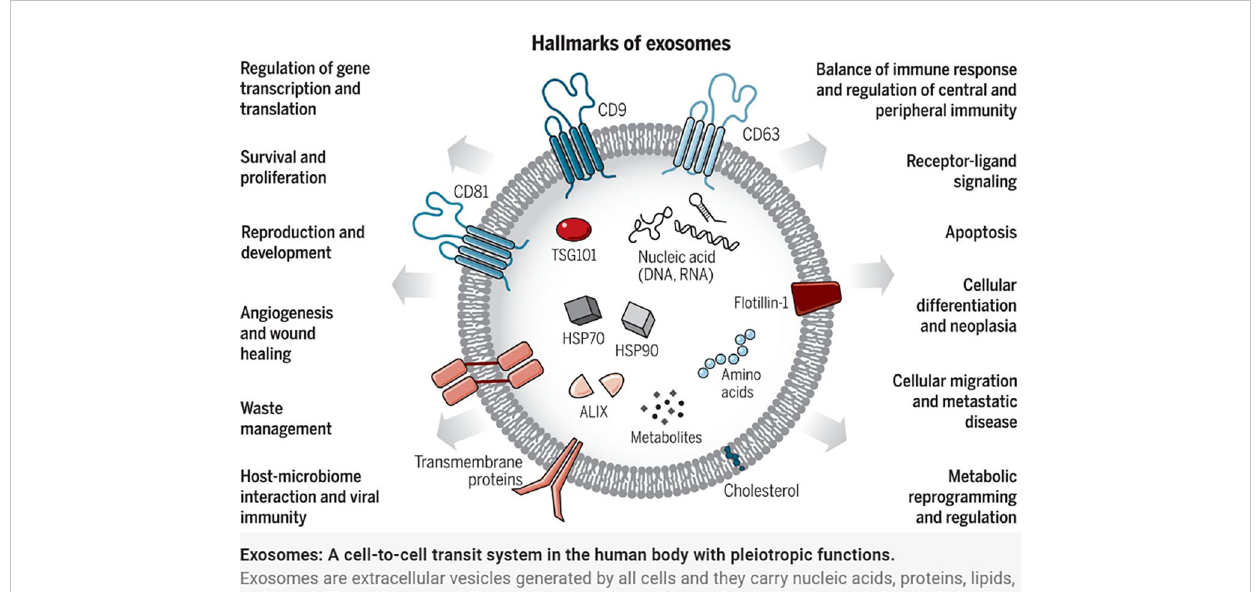
FIGURE 1 Exosomes: A cell-to-cell transit system in the human body with pleiotropic functions. Exosomes are extracellular vesicles generated by all cells and they carry nucleic acids, proteins, lipids, and metabolites. They are mediators of near and long-distance intercellular communication in health and disease and affect various aspects of cell biology